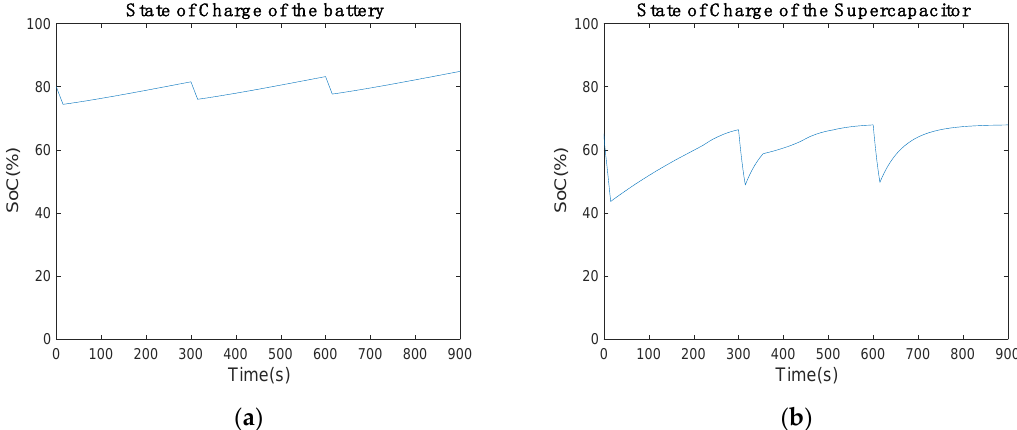
Figure 17. State of charge of the power supply with inductance minimization: ( a ) using the battery and ( b ) using the 2.5 F supercapacitor.